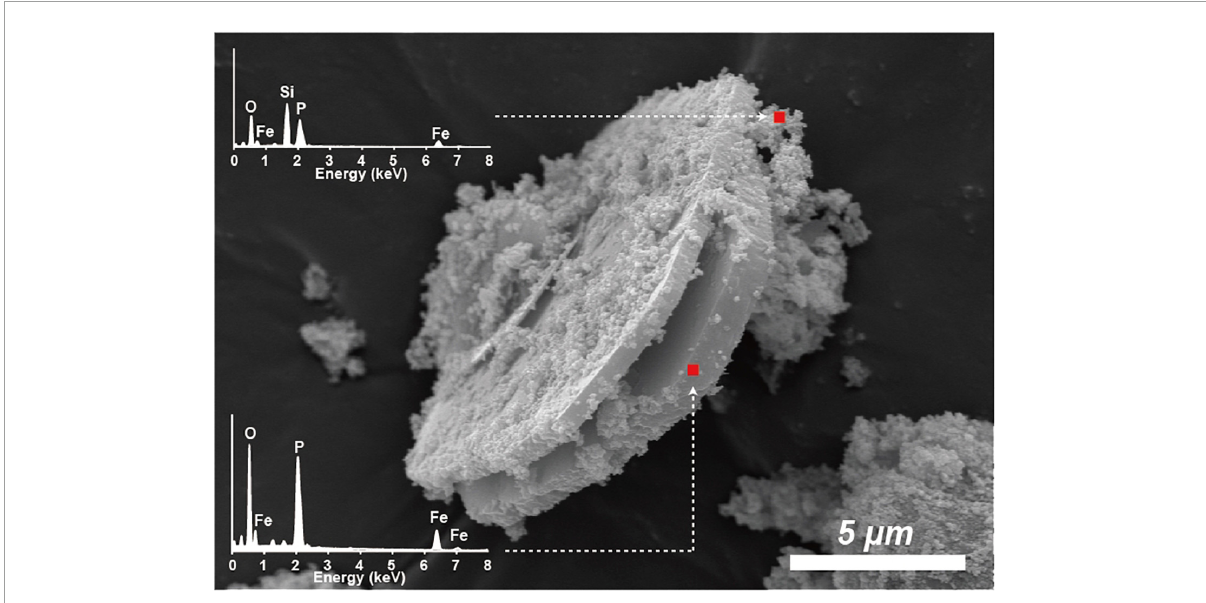
FIGURE5 SEM image of euhedral vivianite crystal and nano-sized aggregated silica in bioreduced sample after 24 ◦ weeks incubation. Elemental composition of Fe, P, and O in EDS